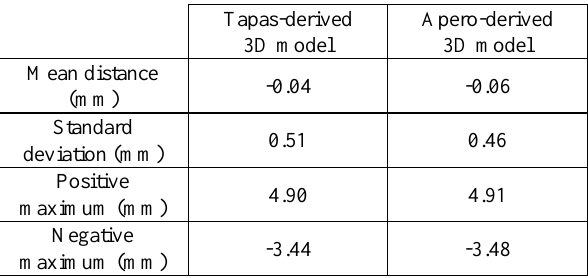
Table 6. Comparison between the corbel image-based 3D models and the “ground-truth” data: statistical results